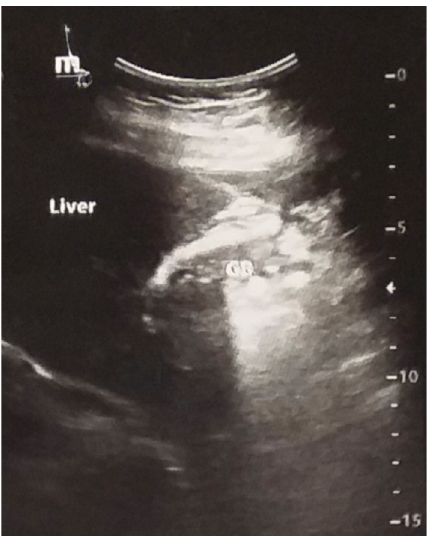
Figure 1: Scleroatrophic (shrunken) gallbladder with a normal biliary tree at abdominal